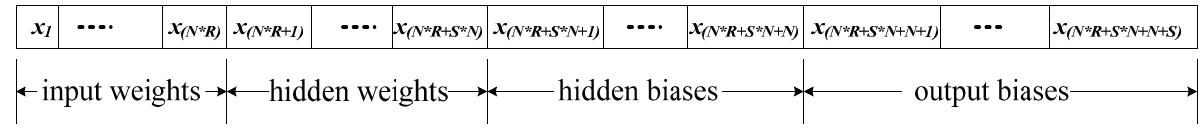
Figure 2. The vector of training